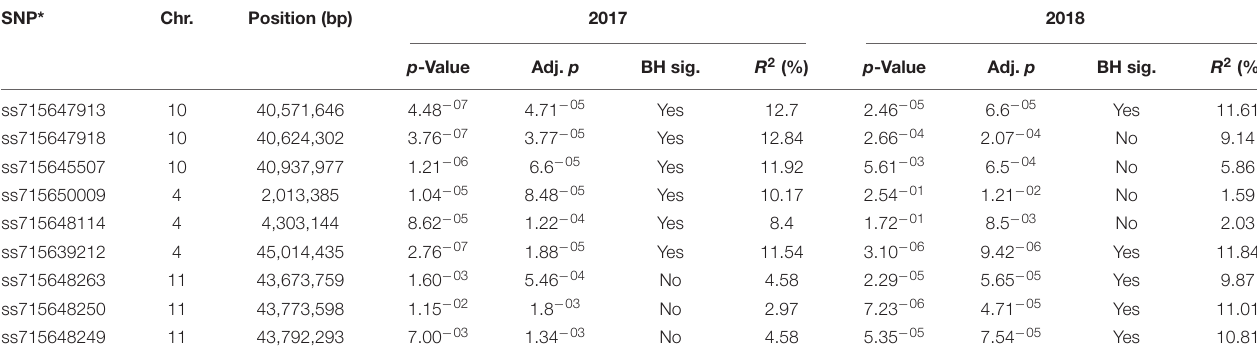
TABLE 2 | Marker–trait association showing significant SNPs, chromosome position, and contribution to phenotypic variation for powdery mildew disease in 2017 and 2018. SNP* Chr.